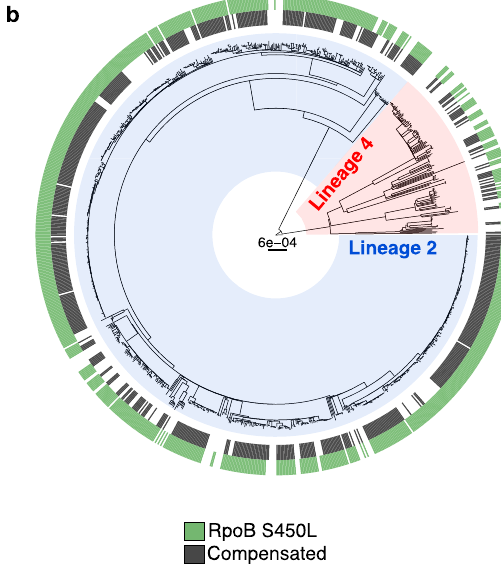
Fig. 1 | The population structure of M. tuberculosis in the country of Georgia. Maximumlikelihoodphylogenyof2,982drug-susceptible M.tuberculosis genomes ( a ) and 980 MDR M. tuberculosis genomes ( b ) collected between 2014 and 2016 in Georgia. Clades coloured in red correspond to L4 strains and clades coloured in blue correspond to L2 strains. The green outer ring in panel B corresponds to